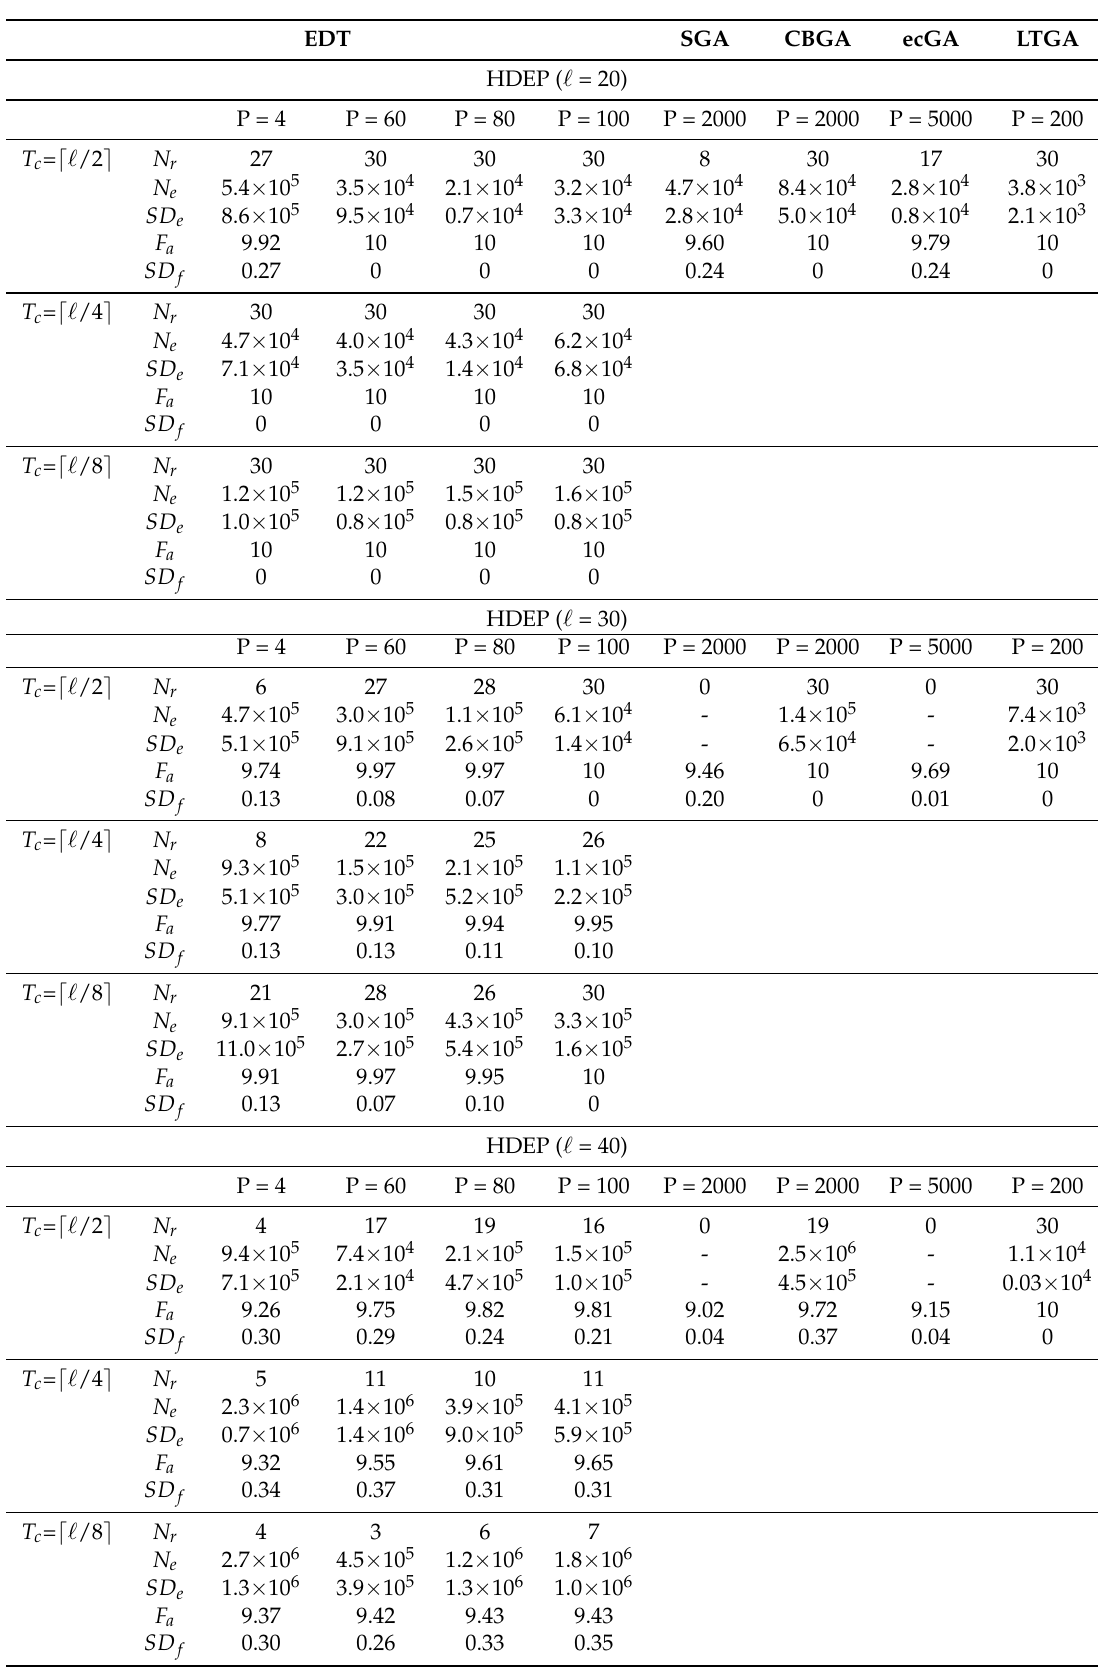
Table 4. The simulation results for